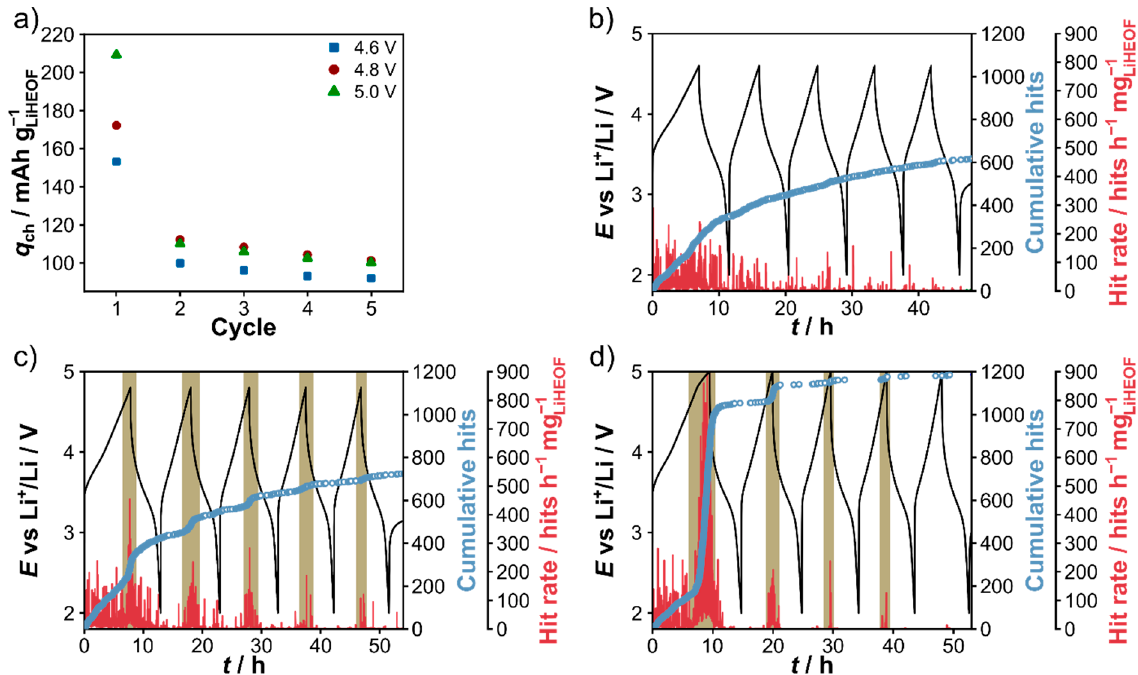
Figure 1. ( a ) Specific charge capacity against cycle number for LiHEOF|Li cells cycled at 25 ◦ C and C/10 rate between 2.0 V and either 4.6, 4.8 or 5.0 V vs. Li + /Li. ( b – d ) Voltage profiles (black) and corresponding cumulative AE hits (blue) and hit rates (red) for ( b ) 2.0–4.6 V, ( c ) 2.0–4.8 V and ( d ) 2.0–5.0 V vs. Li +